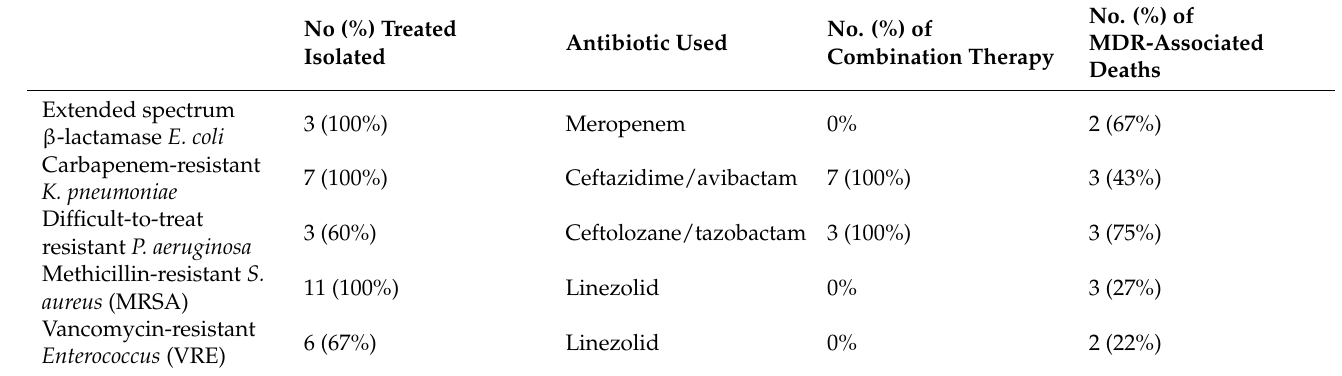
Table 4. Treatment options for MDROs during the second phase of the pandemic at the IRCCS Humanitas Research